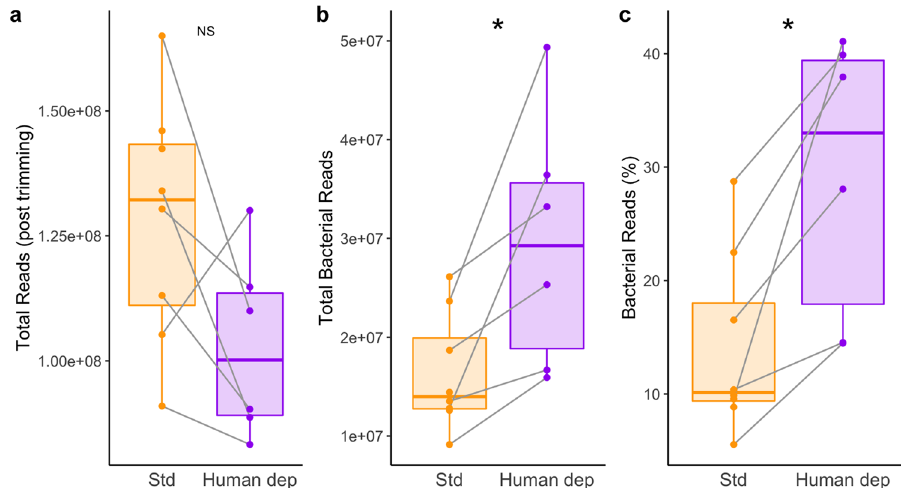
Fig. 5 Bacterial DNA shotgun sequencing ef fi ciency by extraction method (standard or with depletion of human DNA). a Total reads (post- trimming). b Total bacterial reads. c Bacterial reads as a percent of total reads; linear mixed effect model, * p < 0.05: NS = p > 0.05. Center line indicates median; box is IQR.